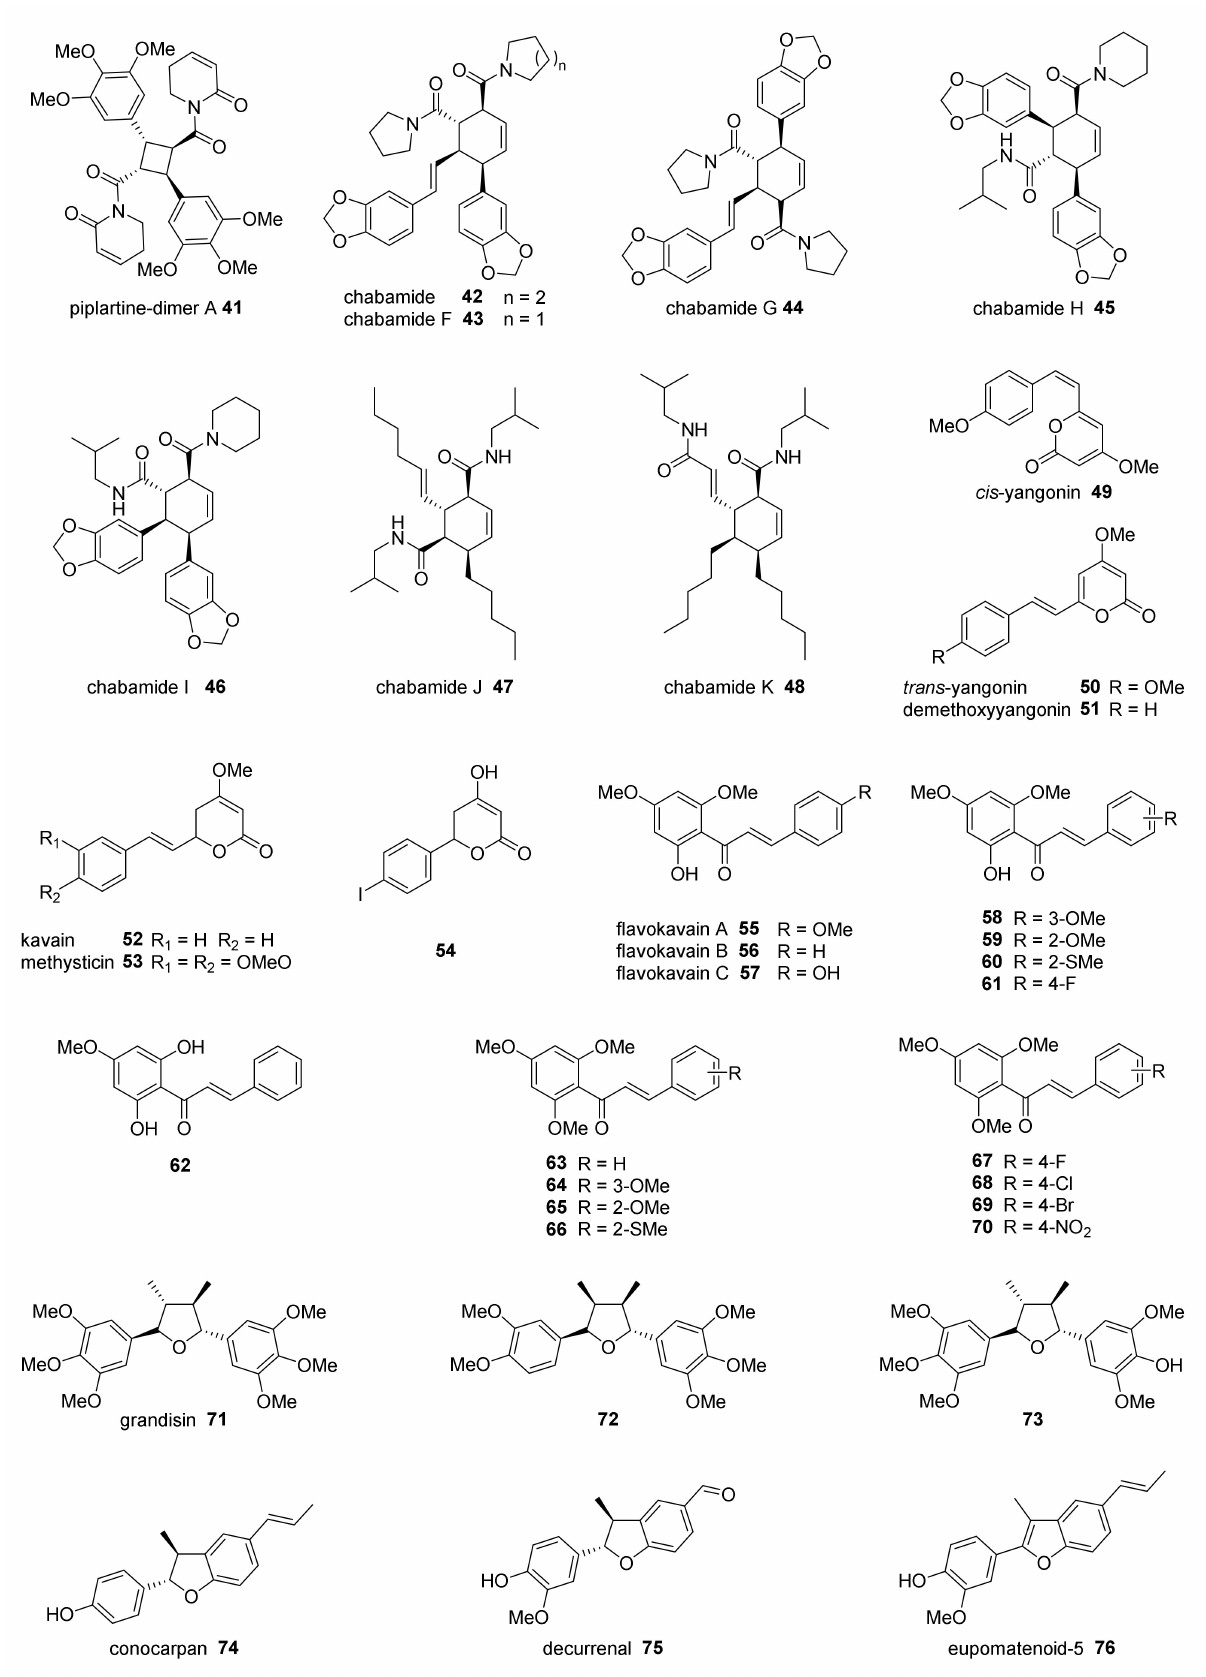
Figure 1. Chemical structures of the reported Piper sp. cytotoxic compounds and